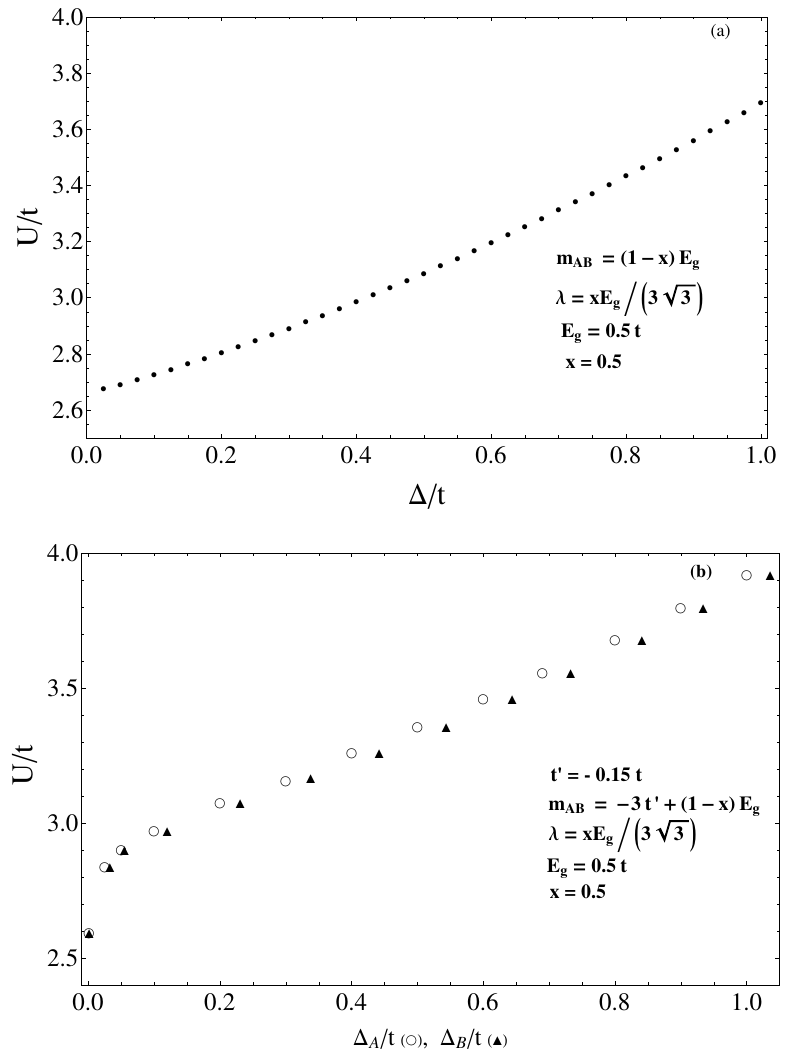
Figure 3. The Hubbard attractive interaction U vs. the s-wave gap (gaps) calculated for x = 1/2: ( a ) t (cid:48) = 0, ( b ) t (cid:48) = − 0.15 t